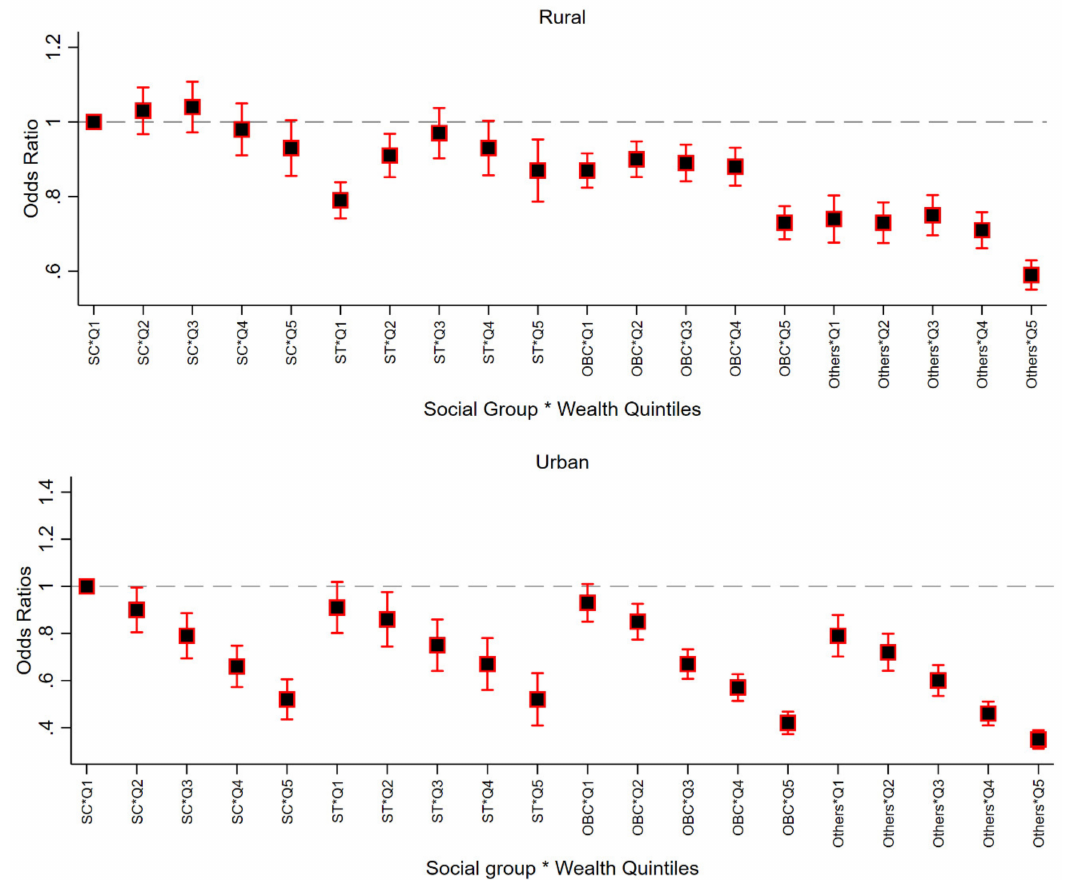
Figure 2. Adjusted odds ratios of service utilization (any) by caste–wealth categories of mothers, stratified by rural-urban location, NFHS, 2016; Note: Odds ratios estimated from a four level (state, district, cluster and individual) logistic regression adjusted for child’s sex, mothers’ age and mother’s education. Q1: lowest wealth quintile; Q2: second wealth quintile; Q3: third wealth quintile; Q4: fourth wealth quintile; Q5: highest wealth quintile; SC: schedule castes; ST: schedule tribes; OBC: other backward